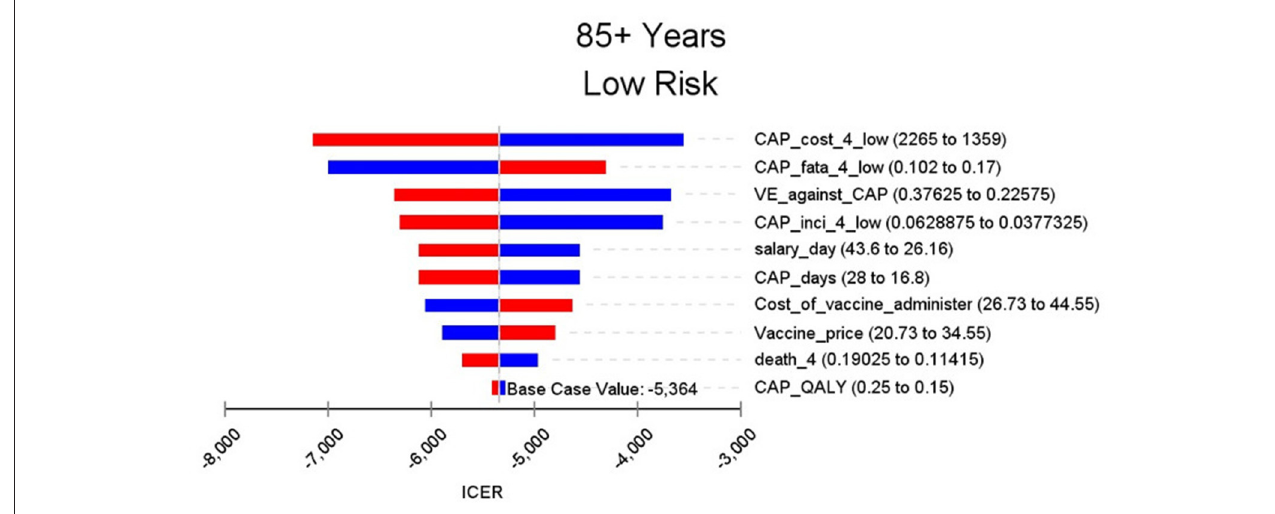
FIGURE 8 | Sensitivity analysis in group 85 + years and low risk.